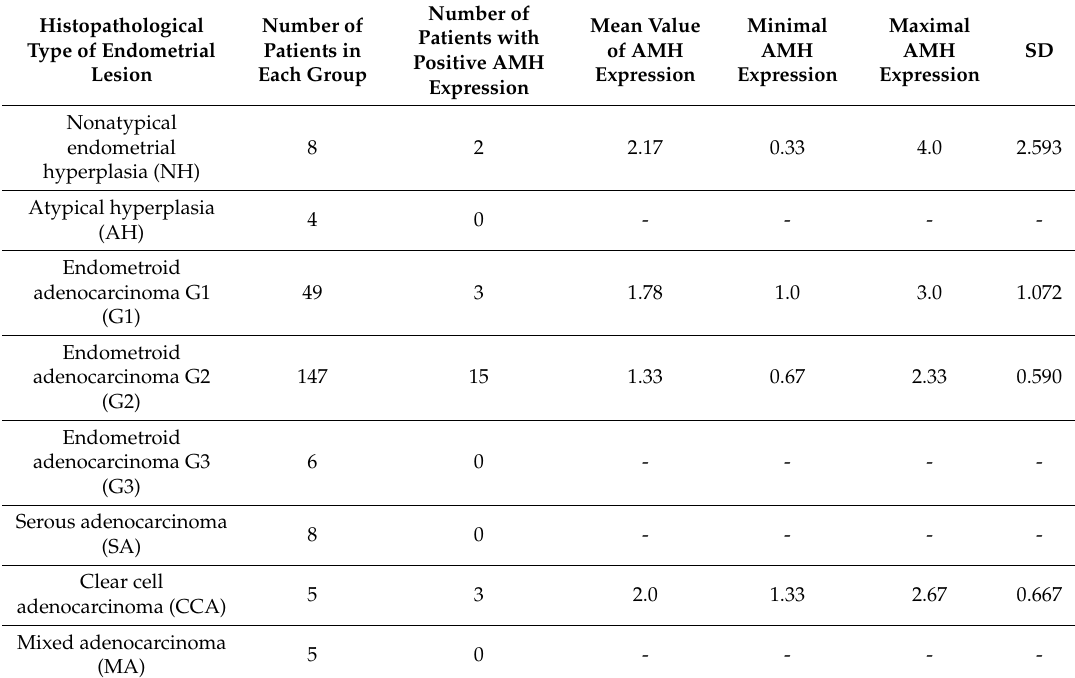
Table 1. Summary of histopathological type of endometrial lesion, number of patients in each group and mean, minimal and maximal values of AMH expression (F-test with Greenhouse-Geisser correction, ἐ = 0.714, p =